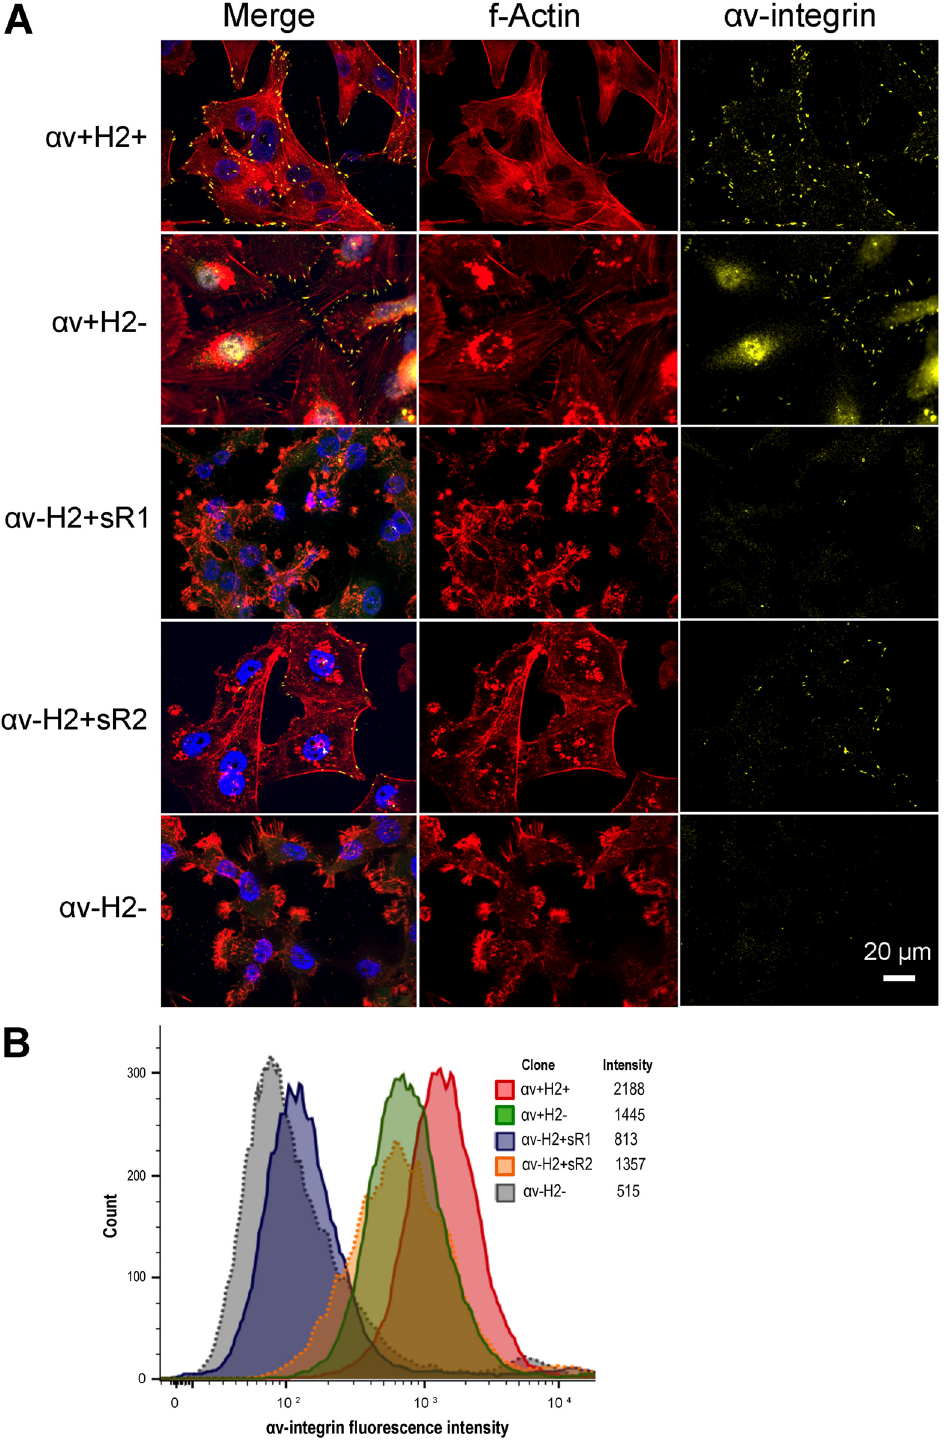
Fig 2. Characterization of cell morphology, actin cytoskeleton and focal adhesions in breast cancer cells. MM2BH clones grown on glass coverslips were stained for α v-integrin and actin filaments. The images are representative of three independent experiments. Yellow: α v-integrin, red: f-actin, blue: nucleus. Scale bar = 20 μ m. (B) Flow cytometry analysis of cell surface α v-integrin protein expression in live MM2BH clones.